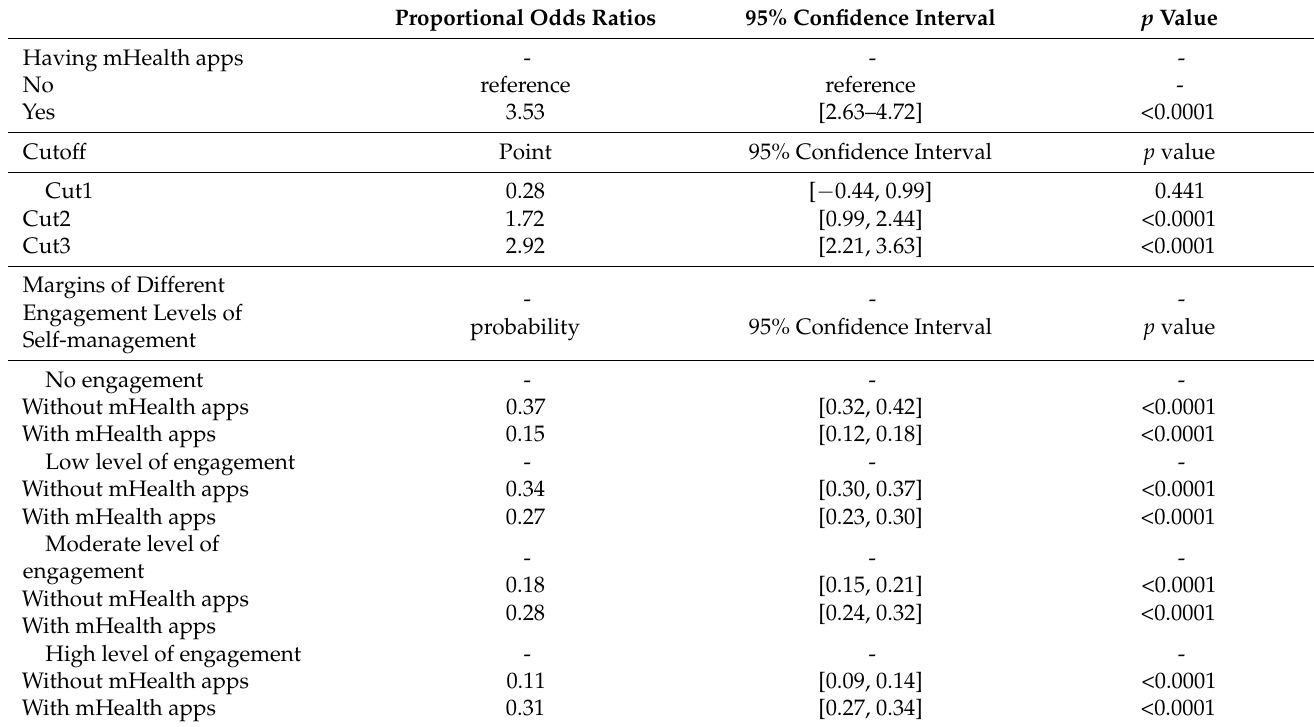
Table 3. Having mHealth apps was associated with different engagement levels of self-management behavior. Proportional Odds Ratios 95% Confidence Interval p